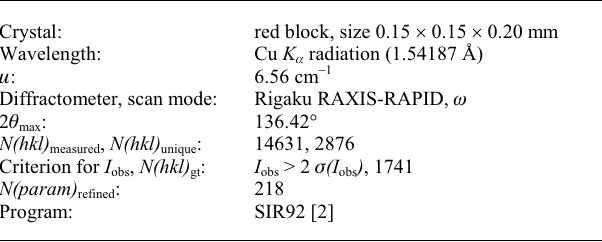
Table 1. Data collection and handling.